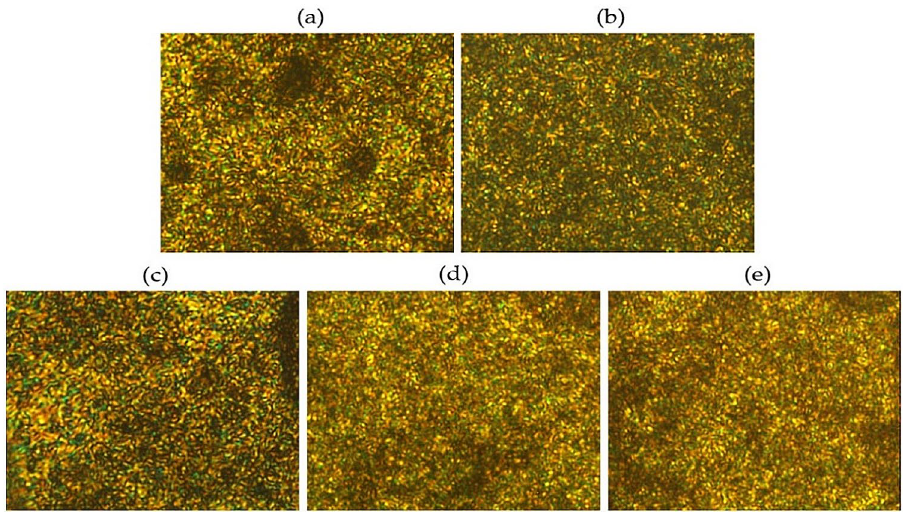
Figure 4. Polarized optical micrographs of TLCP fibers with various heat treatment temperatures (magnification 200×): ( a ) as-spun, ( b ) 190/3, ( c ) 210/3, ( d ) 230/3, and ( e )